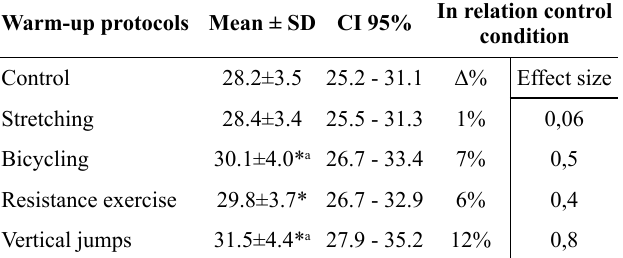
Table 2. VCMJ performance changes following warm-up protocols (n = 8)